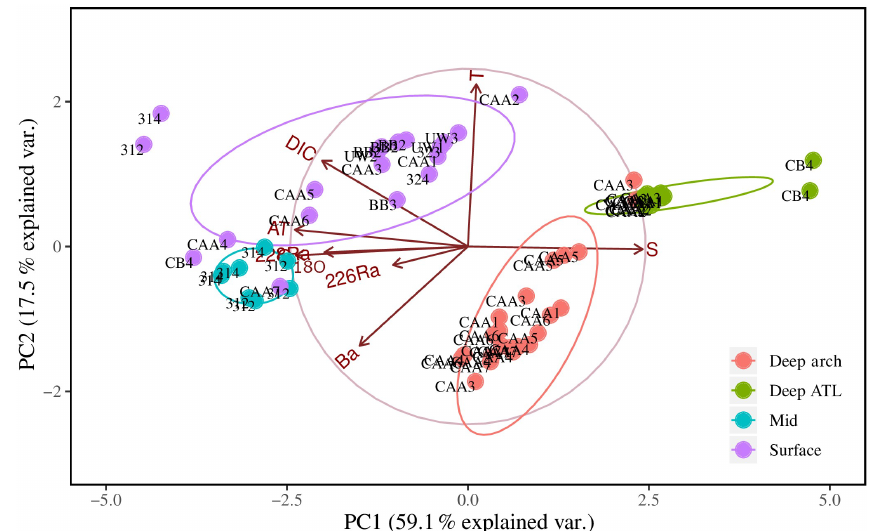
Figure 7. Eight-variable principal component analysis (PCA) of PC1 and PC2 for 64 samples from 17 stations throughout the Canadian Arctic Archipelago, distinguished by depth groupings: surface (0–20m; purple), mid (20–80m; blue), and deep archipelago (deep arch, 80–500m; red), and deep Atlantic (deep ATL, > 500m; green). The sample collected at station CB4 at a depth of 200m was excluded from this plot. The ellipses represent 95% confidence intervals associated with each water mass grouping.